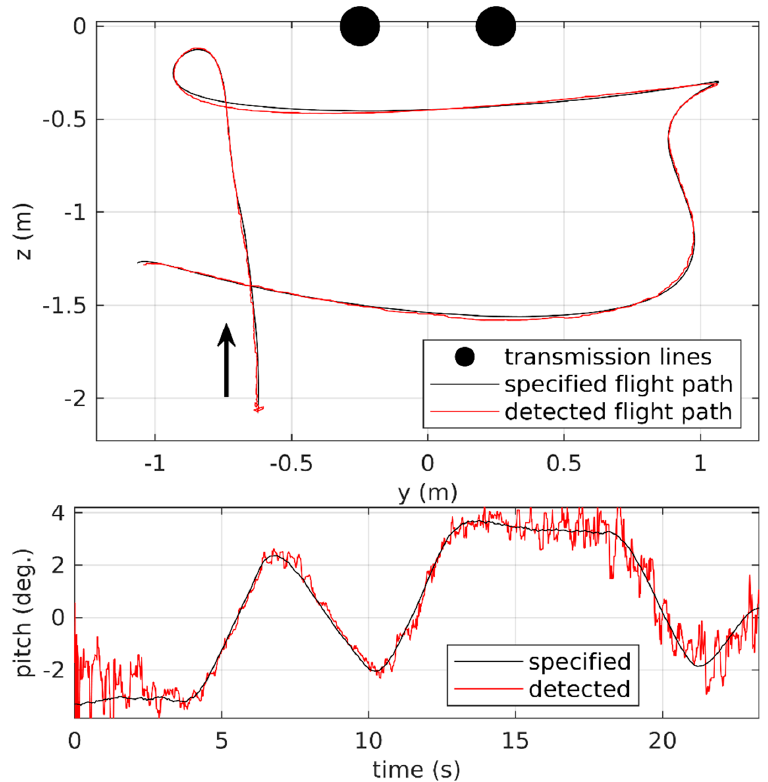
Figure 10. Localization quality, good shielding: σ = 1 μ T.